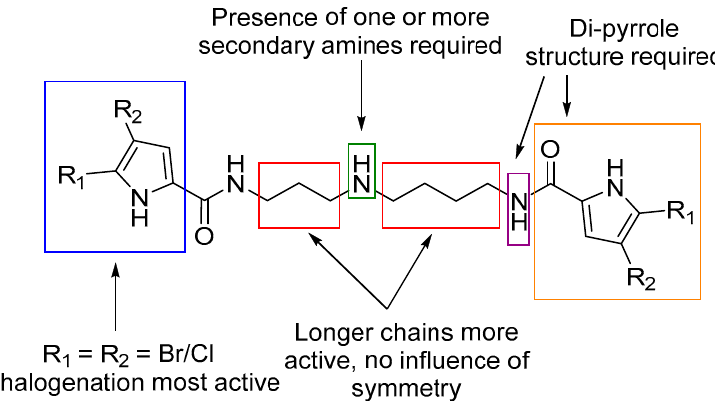
Figure 3. Summary of the SAR of pseudeoceratidine analogues revealed during this investigation. Supplementary Materials: The following are available online. The experimental procedures and characterisation data for all synthesised compounds are provided in the supporting information file.